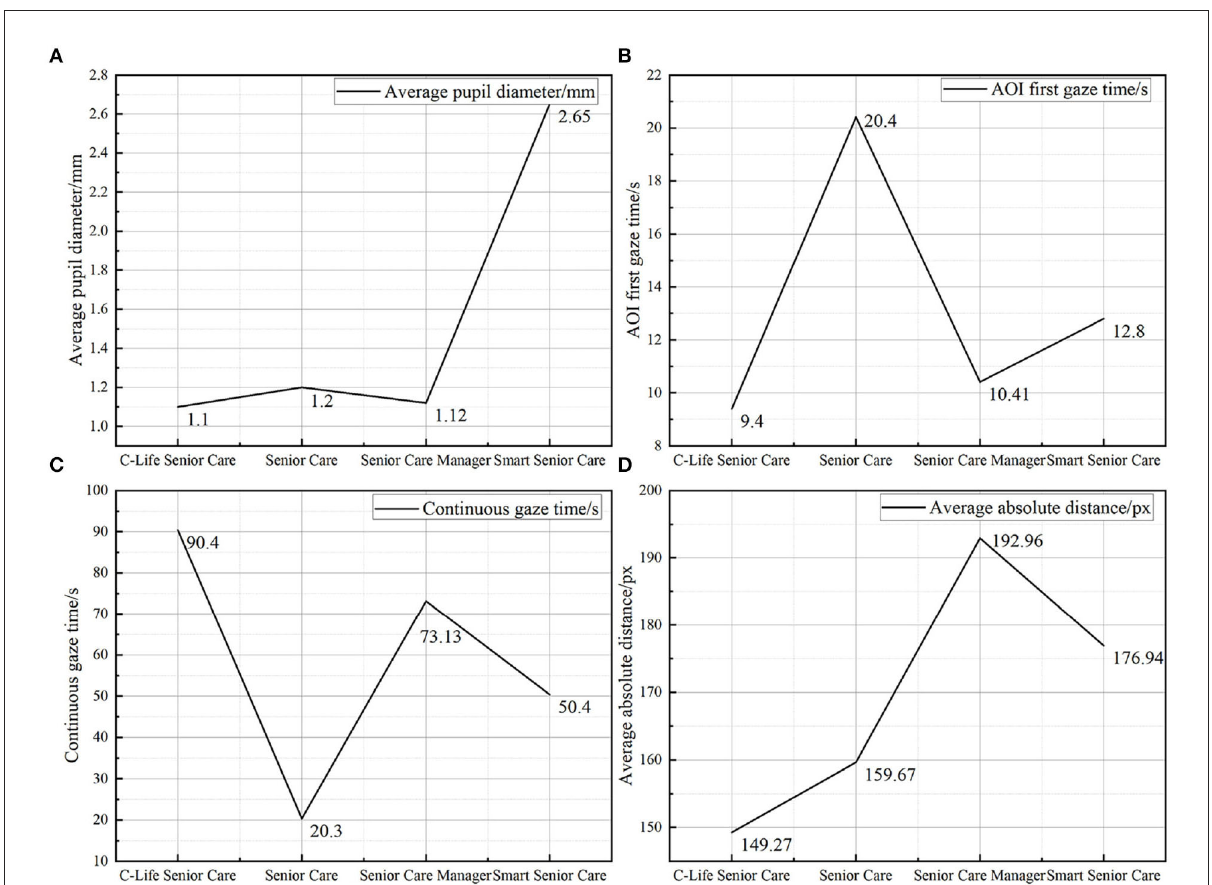
FIGURE2 Eye movement data. Panel (A) is the average pupil diameter of the four products, panel (B) is the first gaze time of AOI of four products, panel (C) is the constant gaze time of four products, and panel (D) is the average absolute distance of the four